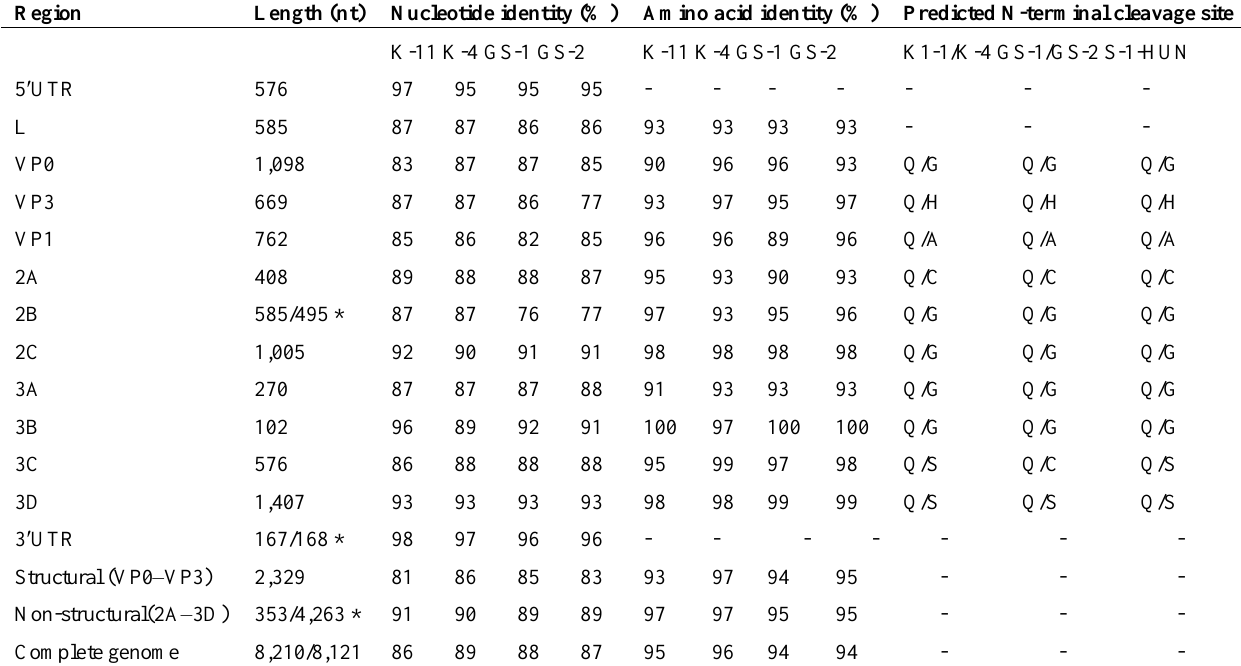
Table 1. Comparison of the nucleotide and amino acid sequences of the study strains to the sequences of